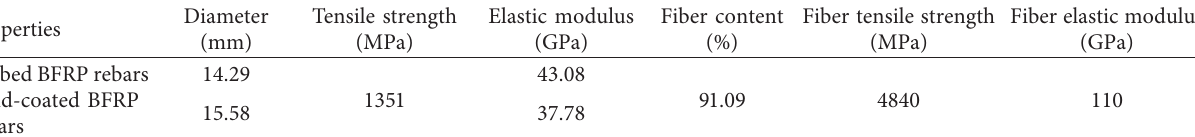
Figure 2: (a) Two types of BFRP rebars and (b) microscopic image of sand coating. Table 3: Mechanical and physical properties of BFRP bars.